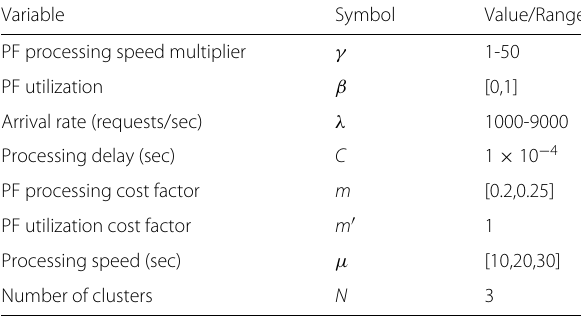
Table 1 Simulation setup and variable